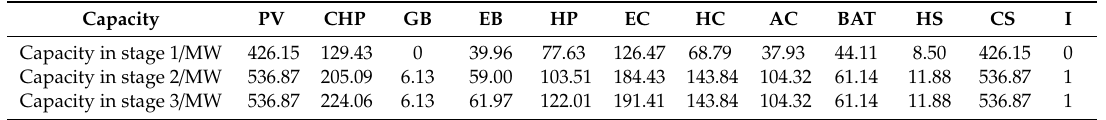
Table 4. The IPIES expansion planning scheme considering regret aversion.